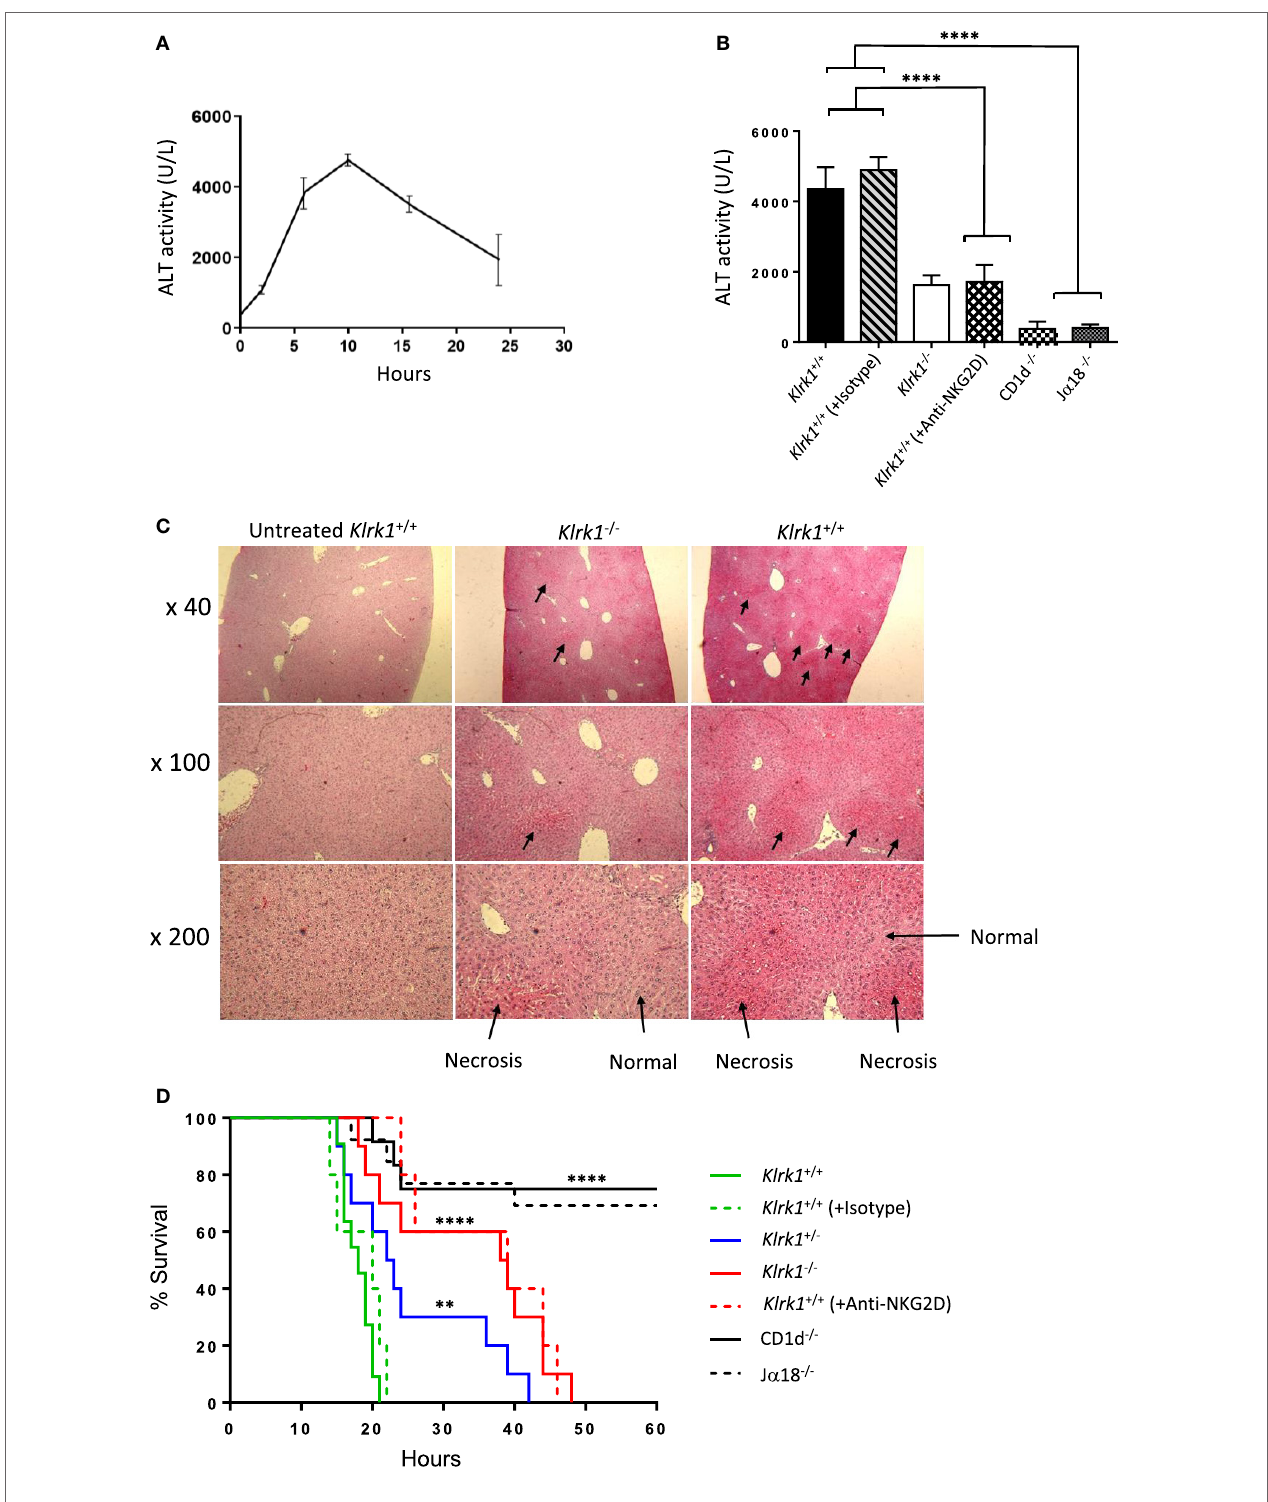
FigUre 4 | Reduced hepatic injury and increased survival in the absence of NK group 2 member D (NKG2D)-mediated signals in concanavalin A (Con A)-induced hepatitis (a) . Kinetics of serum transaminase (ALT) levels in B6 mice after Con A administration (15 mg/kg). (B) ALT levels 10 h after Con A administration (15 mg/kg) in mutant, wild-type, and wild-type mice injected or not with anti-NKG2D neutralizing antibodies. (c) Light micrographs of the liver 10 h after administration of Con A (15 mg/kg) with hematoxylin and eosin stating (40 × , 100 × , 200 × ) are shown. (D) Survival curve of mice injected with lethal dose (25 mg/kg) of Con A are shown. Results are from four experiments where five mice of each genotype were used per experiment. Significance compared to wild type is represented by asterisks and was evaluated by a one-way ANOVA with a Tukey’s post